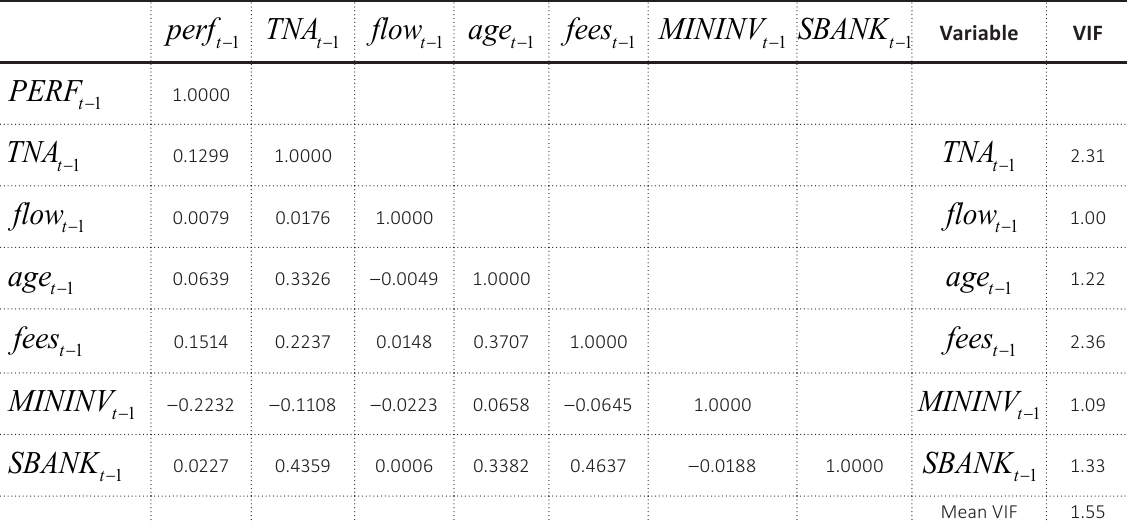
Table 3. Correlation matrix and variance inflation factor